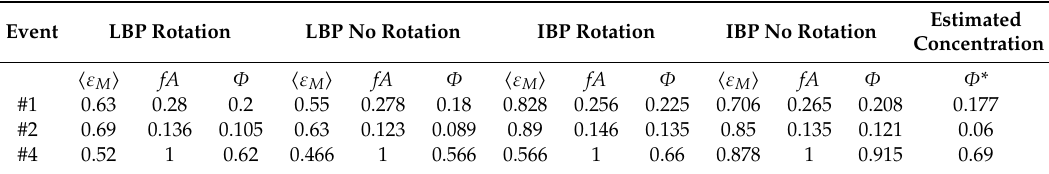
Table 1. Comparison between the average normalized permittivity values < ε M > , fractional areas of solids body f A , and solids concentrations Φ for the 4 di ff erent image reconstruction methods and settled layers #1 and #2 and slug #4. The concentration Φ * estimated from the first plane of the dual-plane sensor (see Figure 4) is also